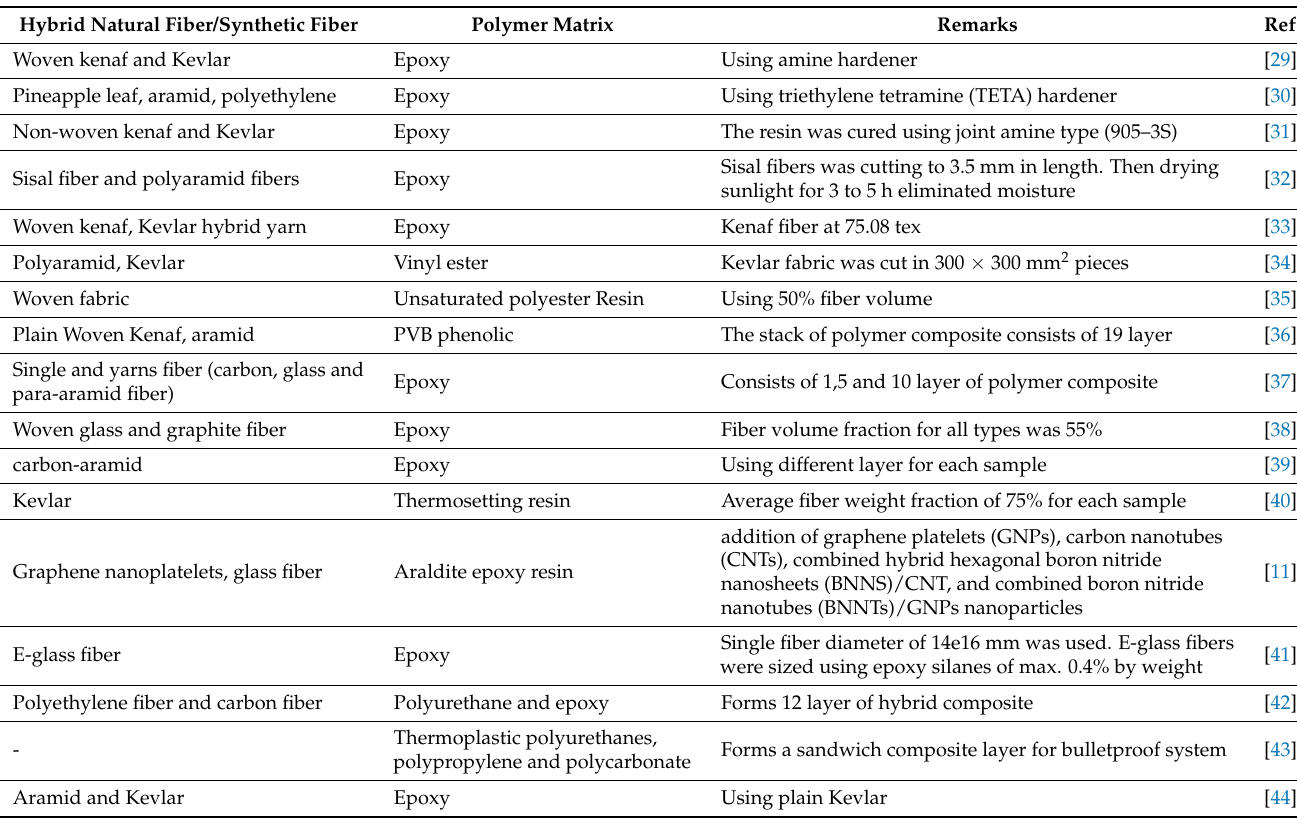
Table 3. Types of hybrid natural fiber/synthetic fiber reinforced polymer matrix use in ballistic